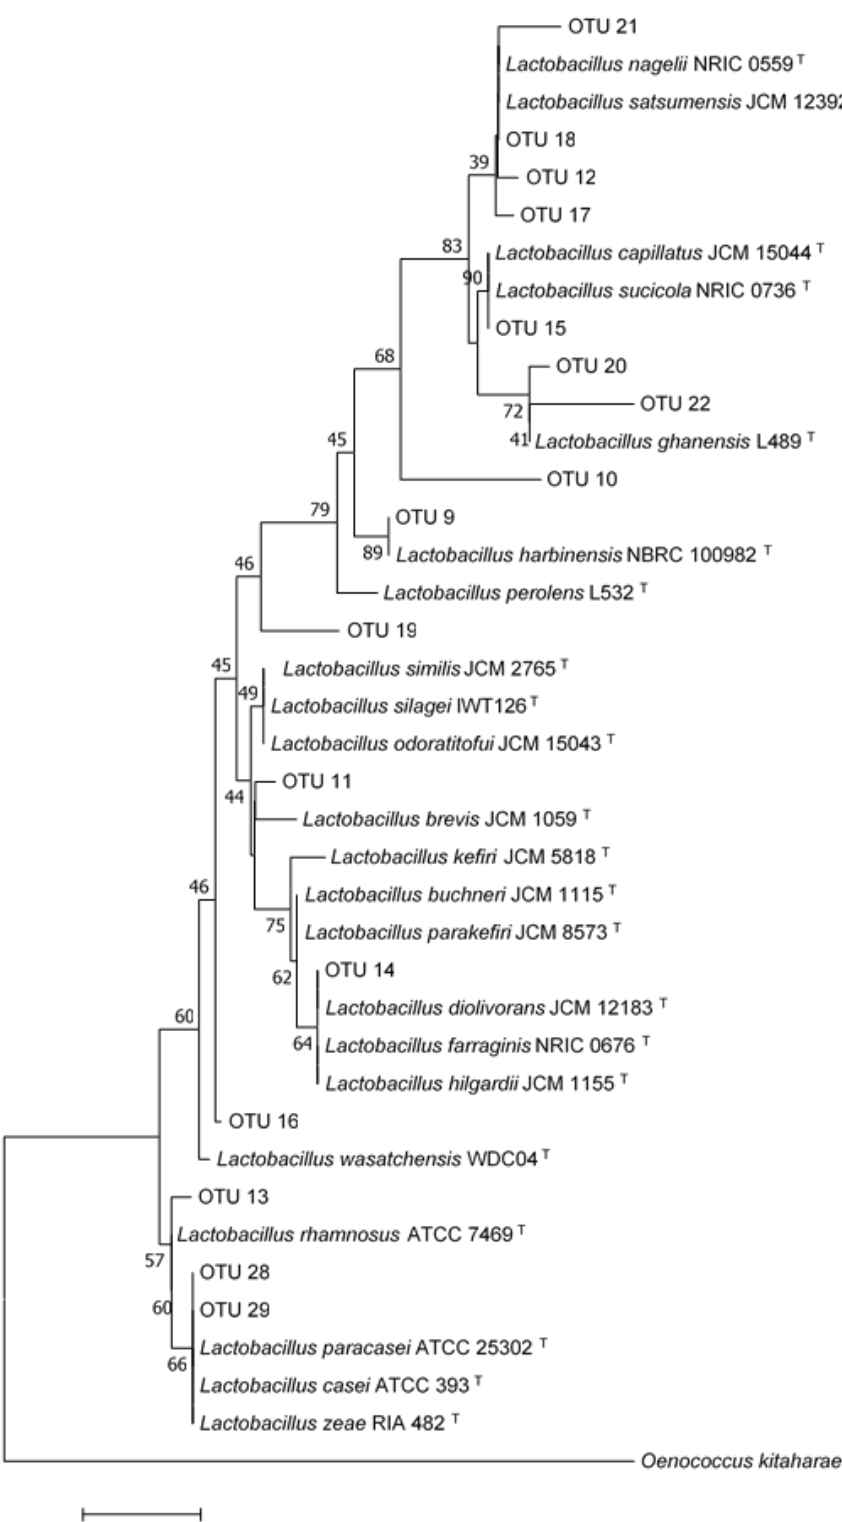
Figure 9. Phylogenetic tree based on OTUs sequences associated with Lactobacillus genus. The tree was constructed using the neighbor-joining method. Bootstrap values (1000 tree interactions) are indicated at the nodes. T- means type strain